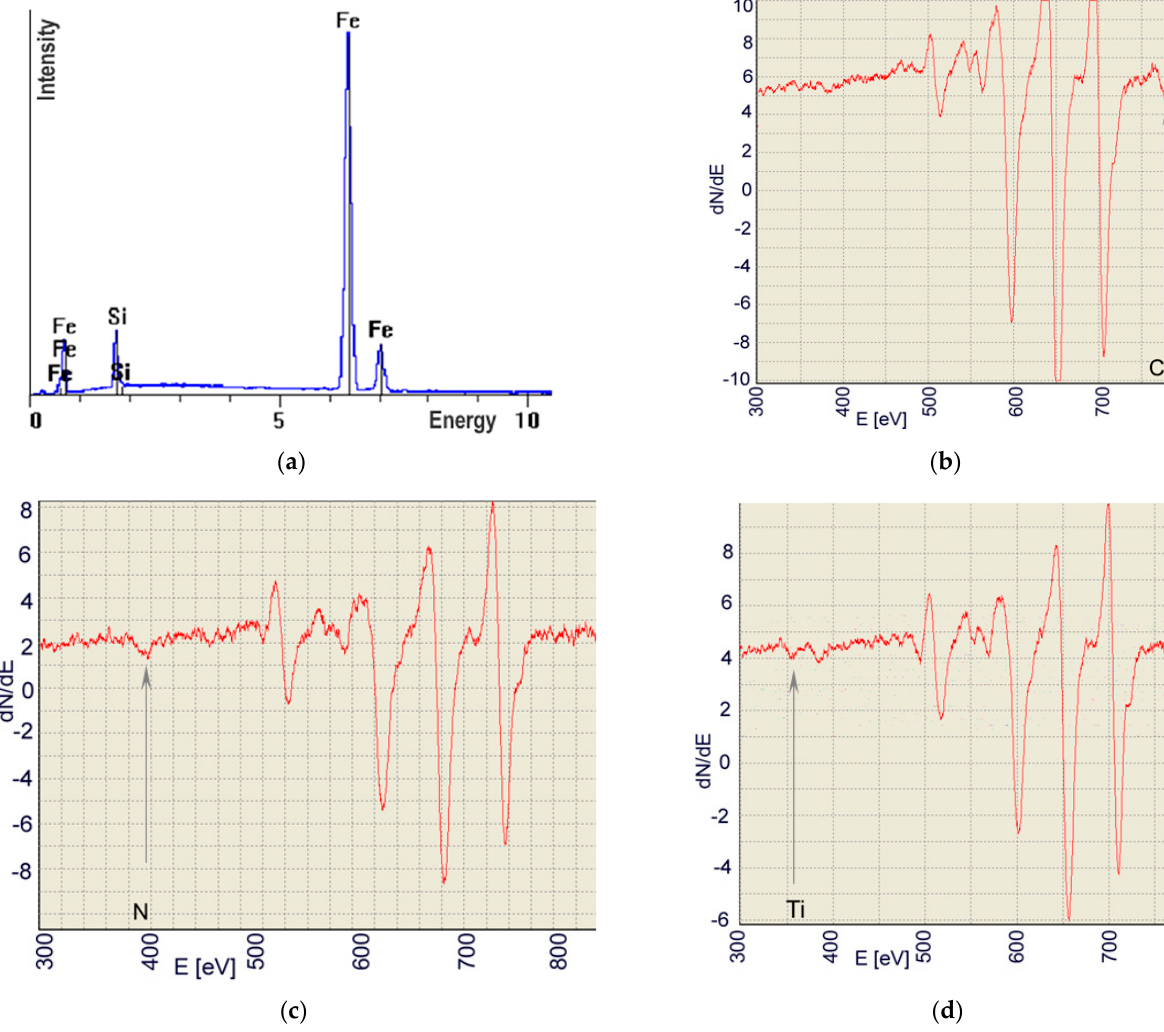
Figure 11. Examples of the AES and EDS spectra of the zones alloyed with: Si ( a ), Co ( b ), Si 3 N 4 ( c ) and Ti ( d ).